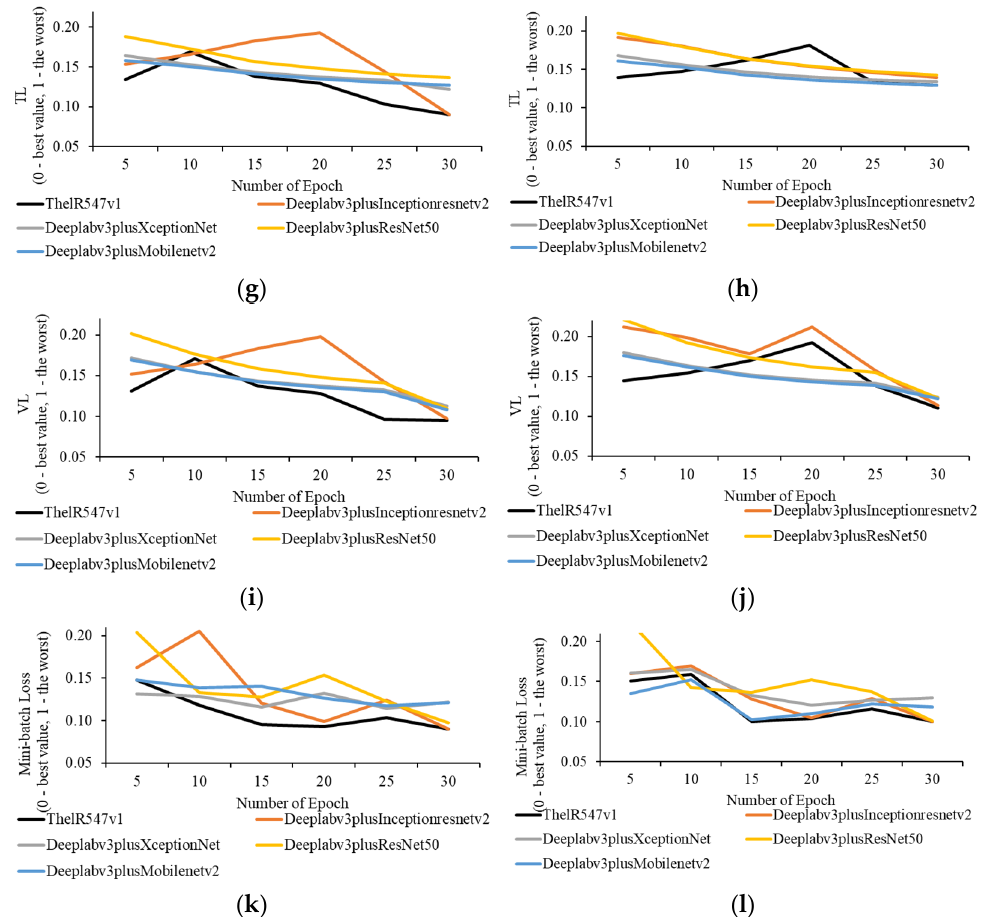
Figure 7. Relationship between number of epoch and network performance using aug1 and aug2 dataset. ( a ) Aug1 dataset. ( b ) Aug2 dataset. ( c ) Aug1 dataset. ( d ) Aug2 dataset. ( e ) Aug1 dataset. ( f ) Aug2 dataset. ( g ) Aug1 dataset. ( h ) Aug2 dataset. ( i ) Aug1 dataset. ( j ) Aug2 dataset. ( k ) Aug1 dataset. ( l ) Aug2 dataset.